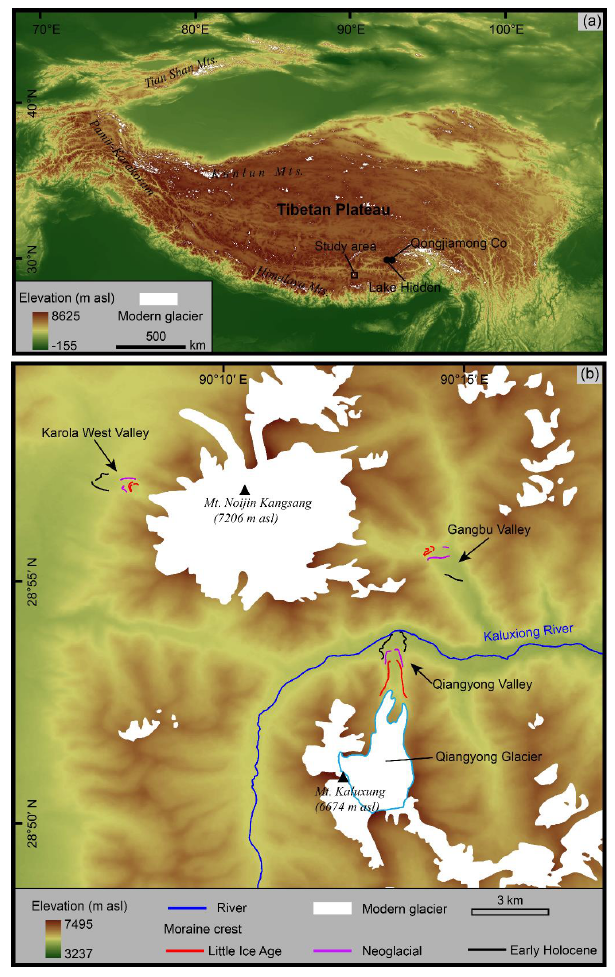
Figure 1. ( a ) Map showing the location of the study area (black box). The background map was drawn using the 30 m ASTER Global Digital Elevation Model V2 (http://www.gscloud.cn/). ( b ) Map showing the location of the dated moraines around the study area. Moraines in Qiangyong Valley were dated by Owen et al. (2005) [18], while moraines in Gangbu Valley and Karola West Valley were dated by Liu et al. (2017) [19]. The Kaluxiong River and moraine crests were delineated from Google Earth image.